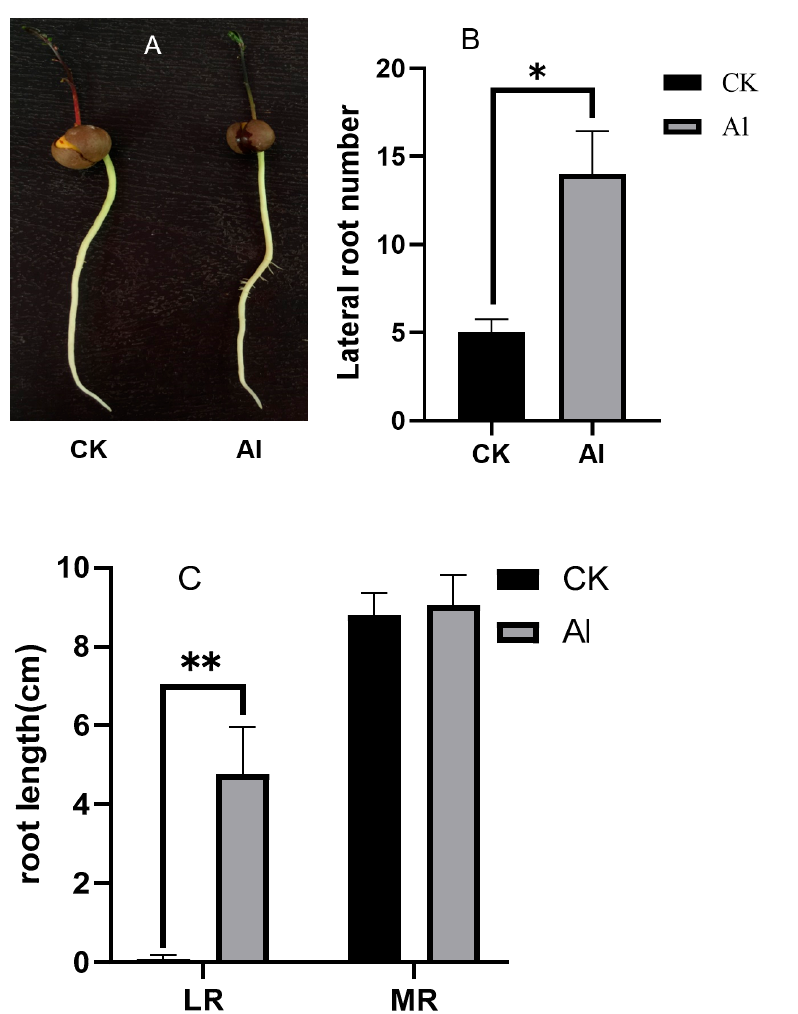
Figure 1. Analysis of lateral roots (LRs) and main root ( MR ) of tea plants for the CK (without Al) and 0.4 mmol/L Al (with Al) groups after 7 d. ( A ) visible phenotypic differences in LR formation; ( B ) differences in the LR number; ( C ) difference in the total root length of LRs and MR (* indicates significance at 0.05 probability level, ** indicates significance at 0.01 probability level).